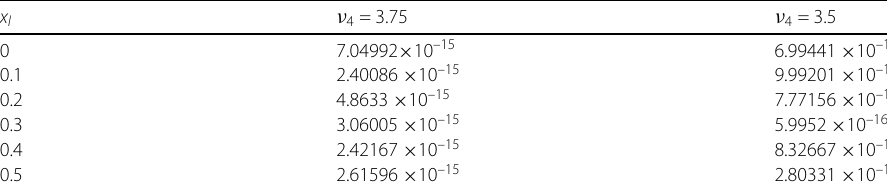
Table 8 Residual error E 10 at ν 4 = 3.75,3.5 for Example 5